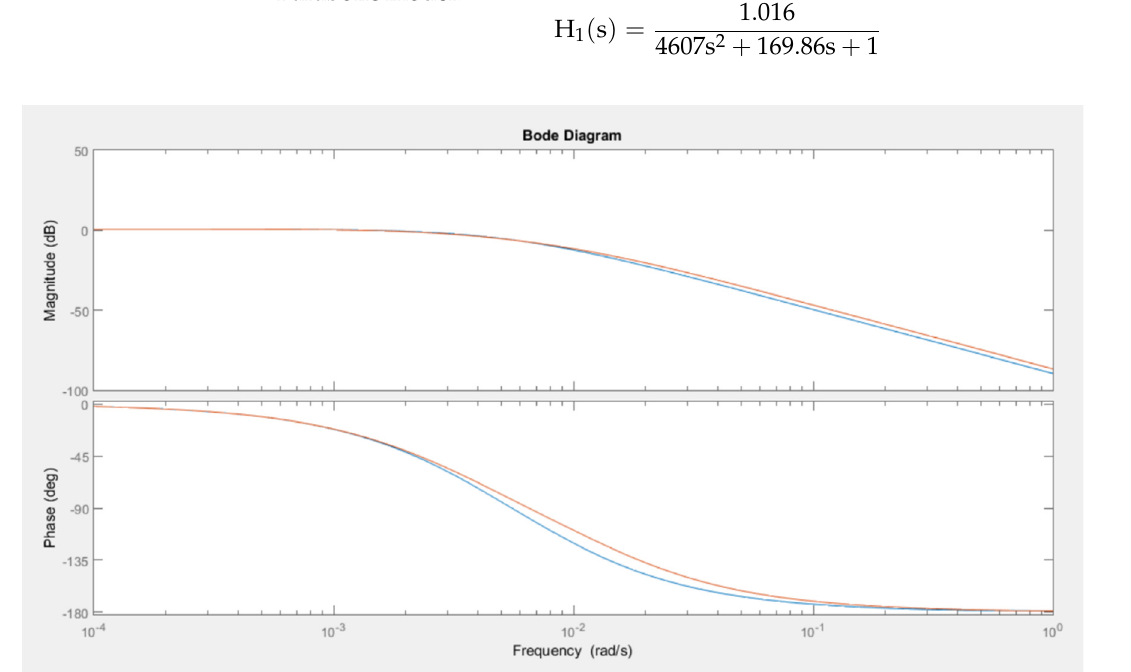
Figure 2. Length = 50 km, diameter = 0.7 m, mass flow = 120 kg/s, T ∈ (0.5 h; 24 h). (c) For L = 50 km, D = 1.0 m, and mass flow = 120 kg/s: (b) For L = 50 km, D = 0.7 m, and mass flow = 120 kg/s: